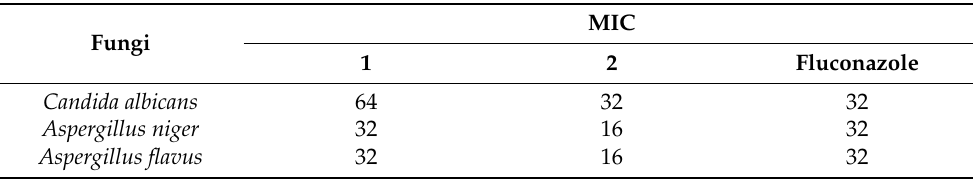
Table 4. MIC ( µ g/ µ L) of the studied compounds.